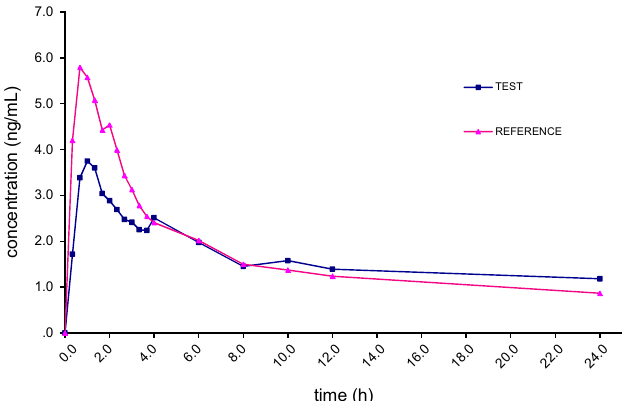
FIGURE 4 - Mean plasma concentration-time profile of healthy volunteers, after single oral dose administration of reference and test products of simvastatin